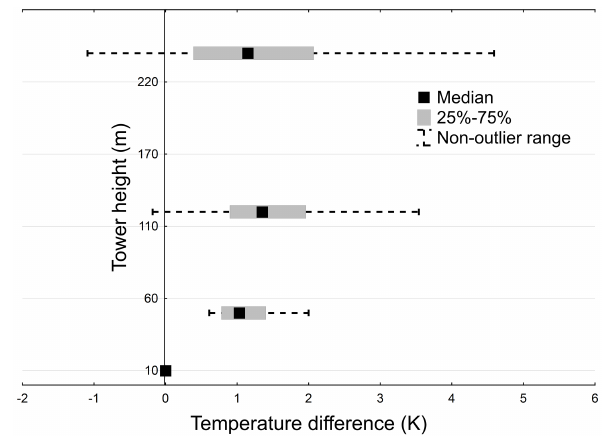
Figure 3. Vertical temperature profile for the stability class of sig- nificant surface inversions (between − 0.05 and − 0.015Km − 1 of the temperature gradient in the layer 10–50m) in summer. Differ- ences from the temperature at 10m are